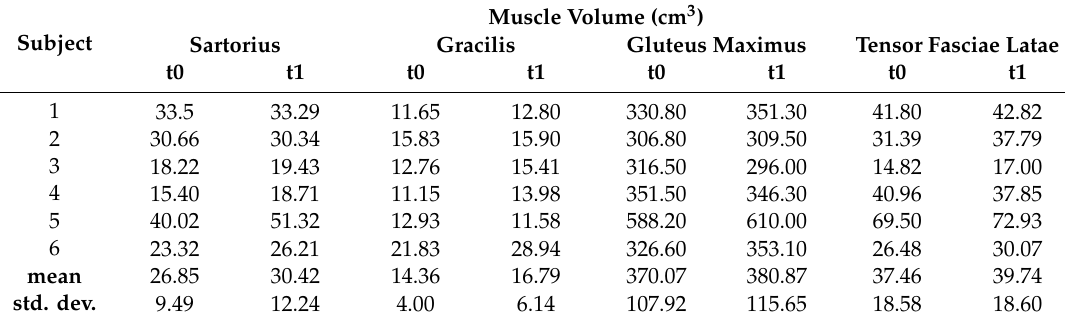
Table 2. Subjects’ muscle ROIs volumes as manually delineated on T1-w images.